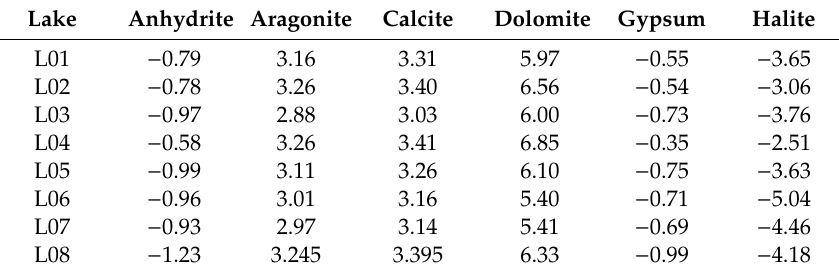
Table 3. Saturation index values of minerals in lake water.